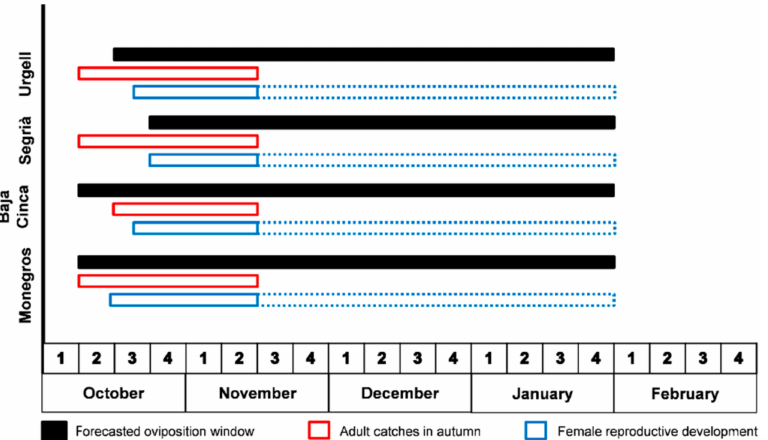
Figure 5. The oviposition windows of Hypera postica for the four areas of the Ebro Valley at the medium relative humidity regime (50% < RH < 75%). Black rectangle: the forecasted oviposition window; Red rectangle: the period with adult catches in autumn; and Blue rectangle: the period with females having mature eggs in the reproductive system/ovarioles. The dashed blue rectangle indicates that oviposition likely continued, although no sampling was made after the third week of